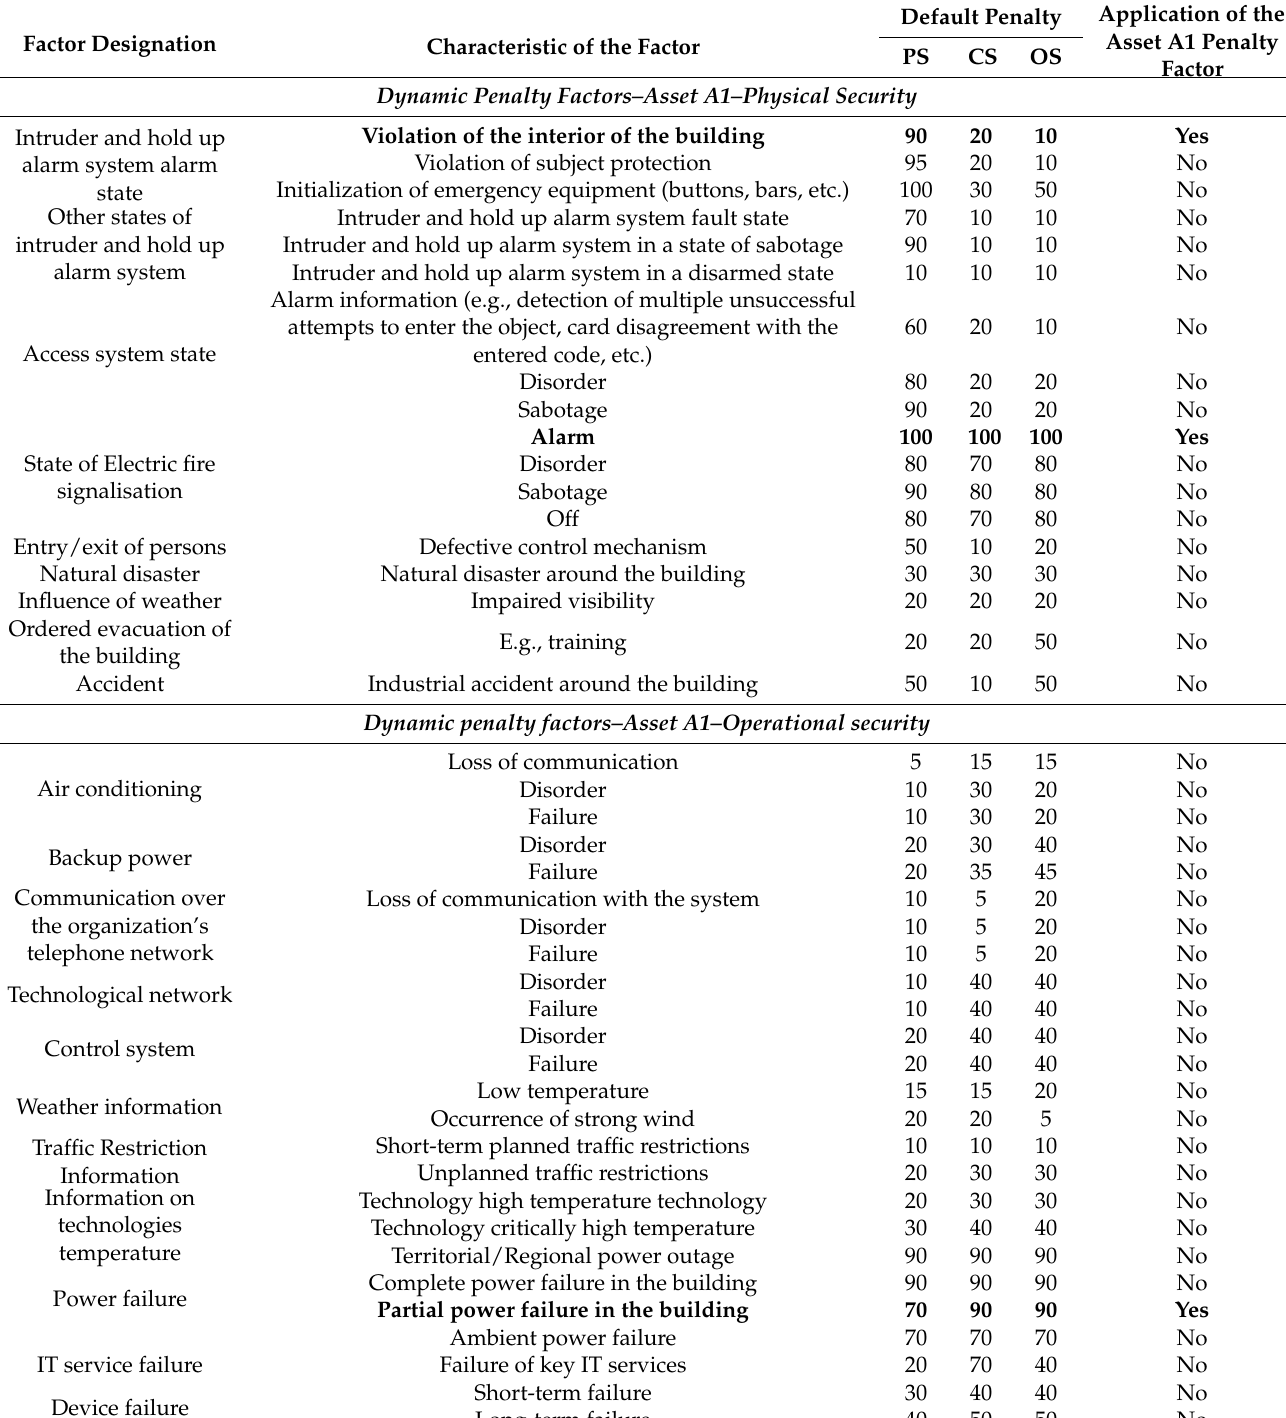
Table 4. Dynamic penalty factors and calculation of the value of selected asset dynamic penalty with respect to the defined